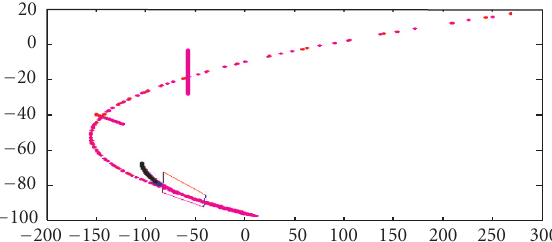
Figure 4.3. The quadrangle ¯ D and its image under the mapping ¯ P 6 . Table 4.2. The vertexes’ coordinates of h 1 , h 2 , h 3 .